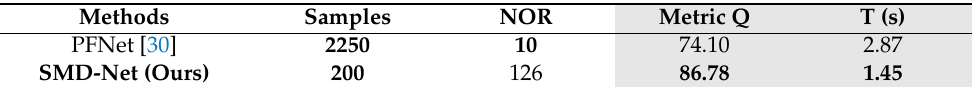
Table 6. The metrics of the PFNet trained with 2250 samples and the SMD-Net trained with 200 sam- ples on area B. Metric Q is the core accuracy index. T is the speed